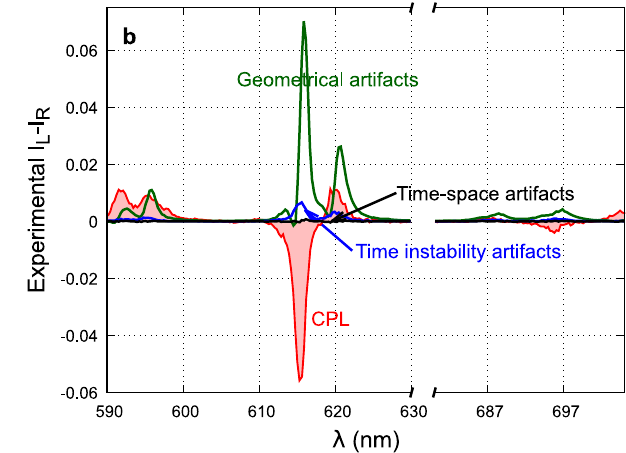
Fig. 5 | Measured CPL artifacts. CPL artifacts of 1 ( a ) and 2 ( b ) were recorded withouttheQWP(green-blueandblack).TocomparetheCPLmeasuredbythefour signals combination is plotted in red. 1 is excited with a λ =450nm laser and 15s integration time. 2 is excited with a λ =365nm emitting diode and 2s integration time. Signals are normalized to the maximum of luminescence. The green curves